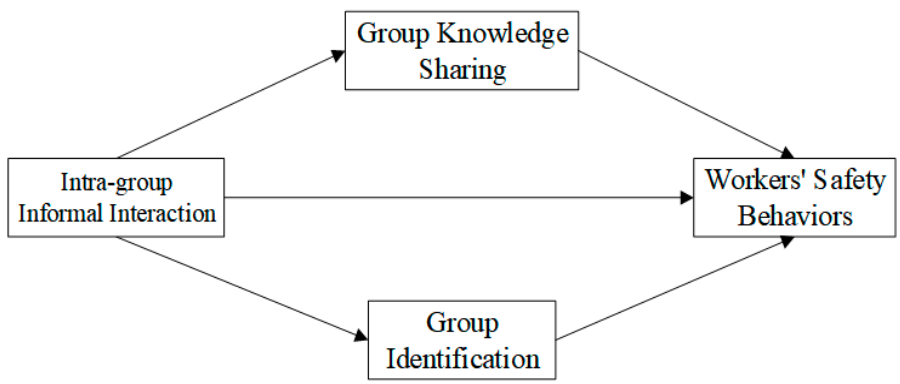
Figure 1. Conceptual model of this study.